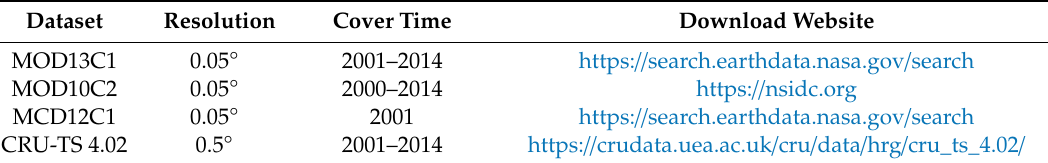
Table A2. Harmonized legend used and correspondence with the original product classes.